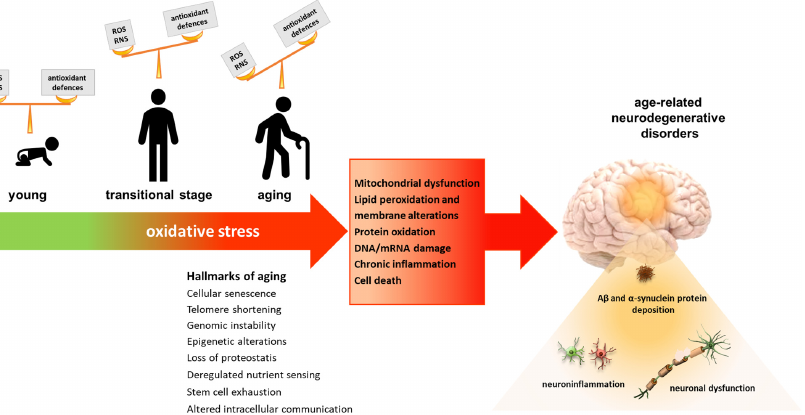
Figure 1. Role of oxidative stress in health, aging, and neurodegenerative diseases. In healthy conditions, levels of ROS/RNS are balanced by efficient mechanisms of defense. However, during aging, the oxidant levels increase, while the antioxidant defences become less efficient, generating an imbalance that leads to oxidative stress. This condition leads to oxidative damage of the main biomolecules, resulting in the development of age-related neurodegenerative conditions such as Alzheimer’s and Parkinson’s